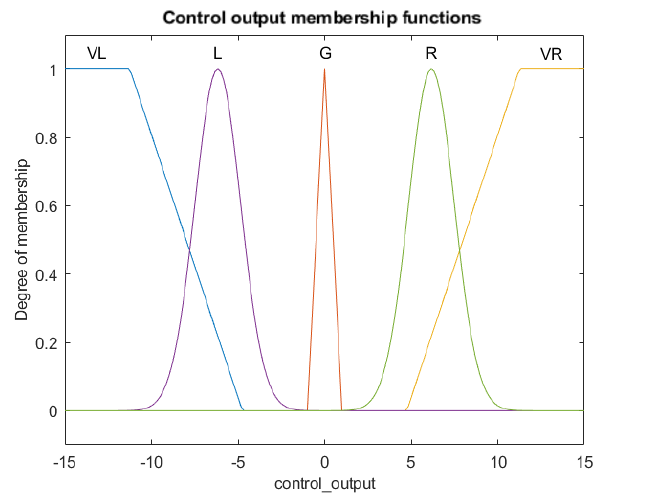
Figure 7. The membership functions of the control output set—the genetic algorithm method.